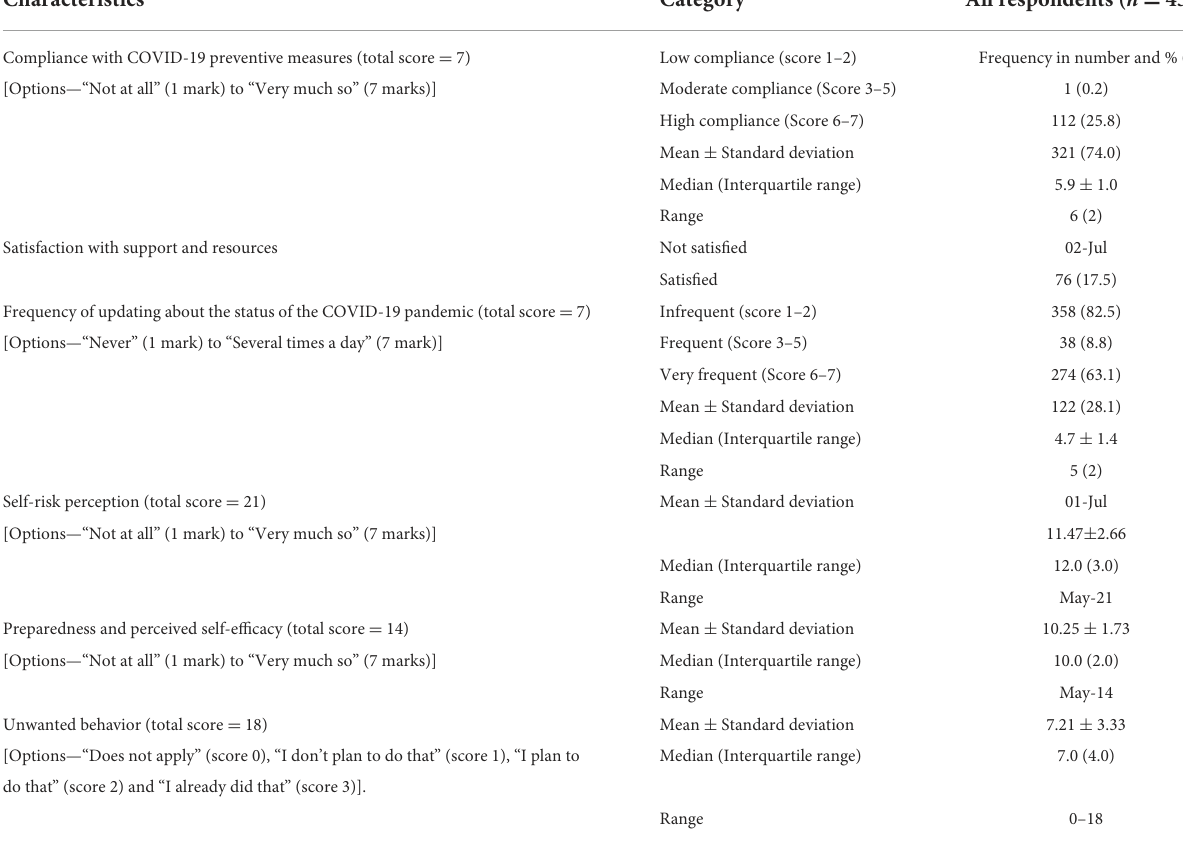
TABLE 2 Compliance with COVID-19 preventive measures, satisfaction with support and resources, frequency of updating about the COVID-19 pandemic, risk perception, self-efficacy, unwanted behavior ( n = 434).